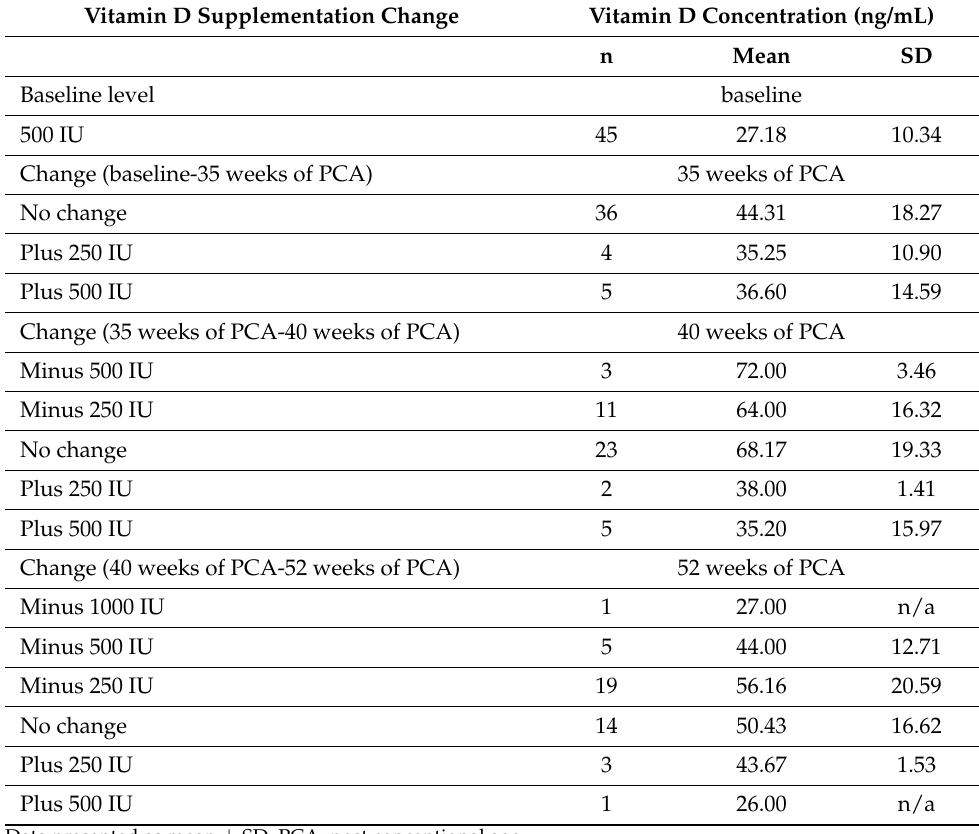
Table 2. Changes in Vitamin D supplementation and their influence on serum concentration in the monitored